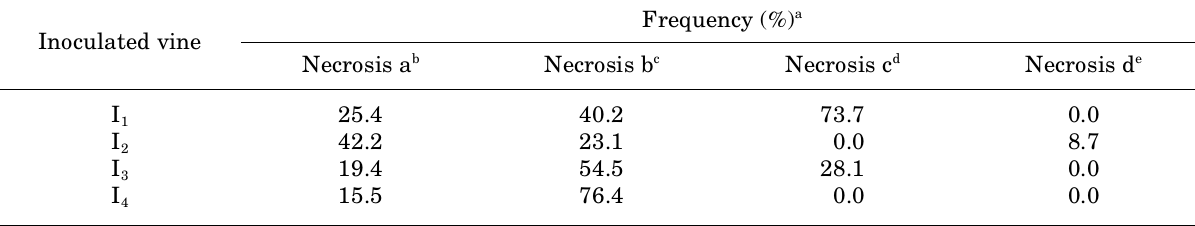
Table 3. Distribution of Phellinus sp. in the different types of necrotic areas in inoculated